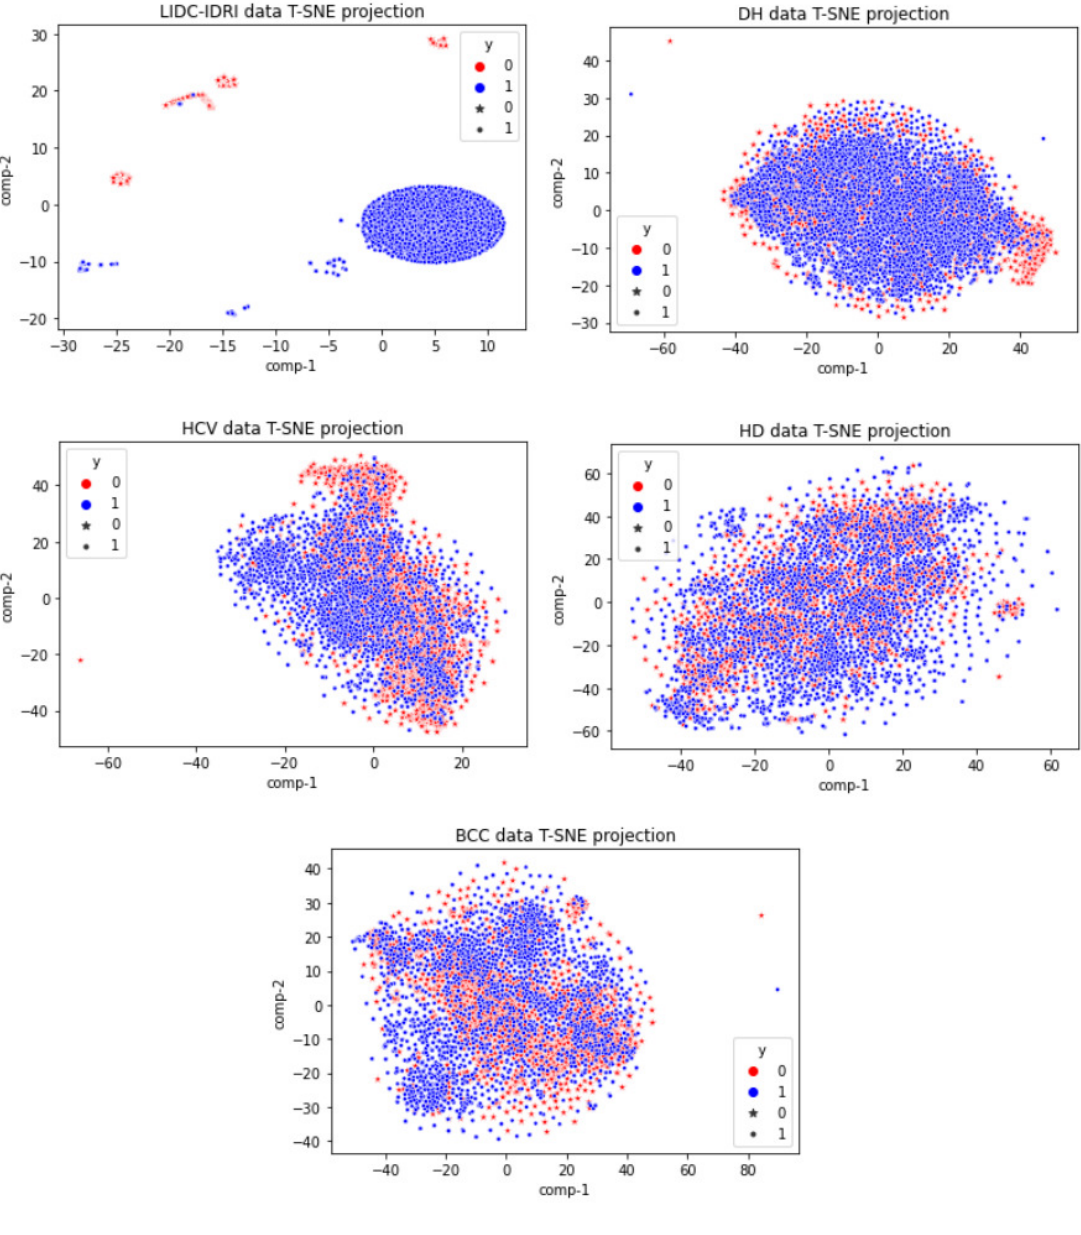
Figure 8. The 2-D distribution of some used data sets using t-distributed stochastic neighbor embedding